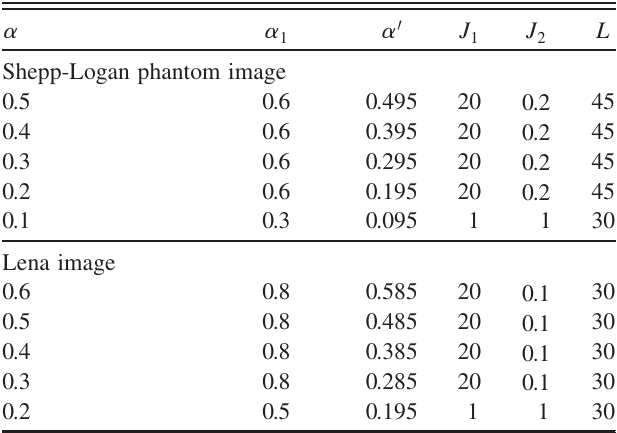
TABLE II. Parameters used for the s-BP reconstruction of the Shepp-Logan phantom image and the Lena image of Fig.